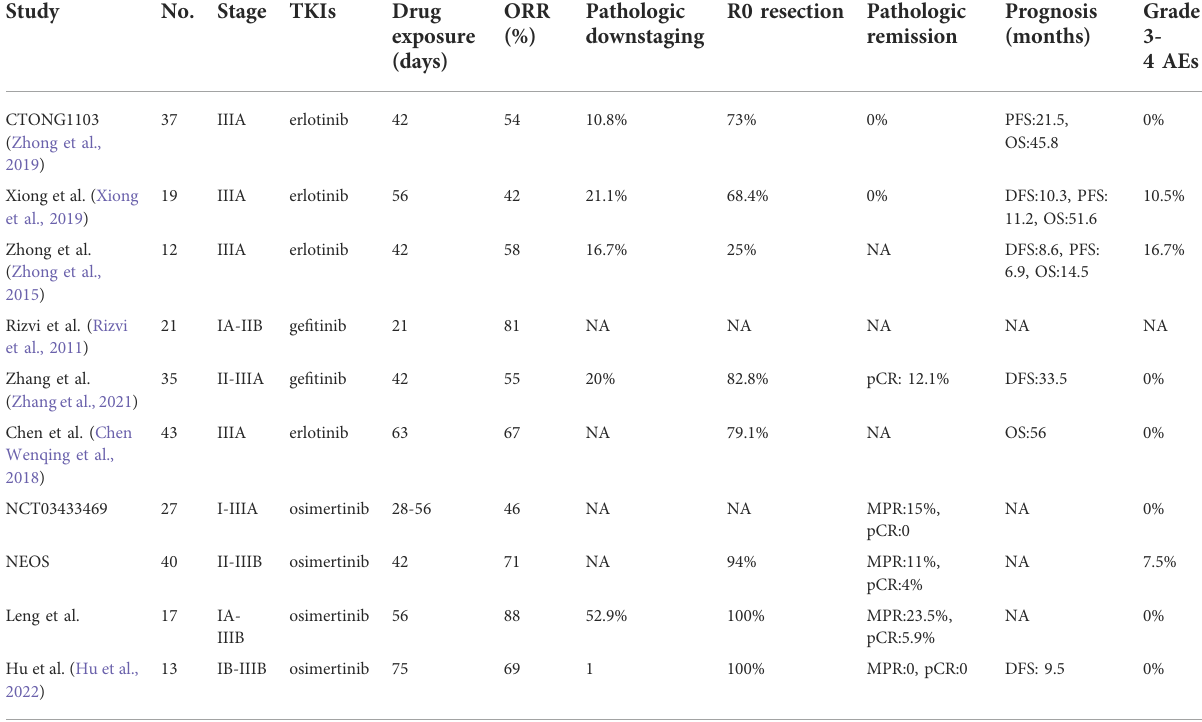
TABLE 1 Neoadjuvant EGFR-TKIs targeted therapy for EGFR-mutated resectable NSCLC with published results.